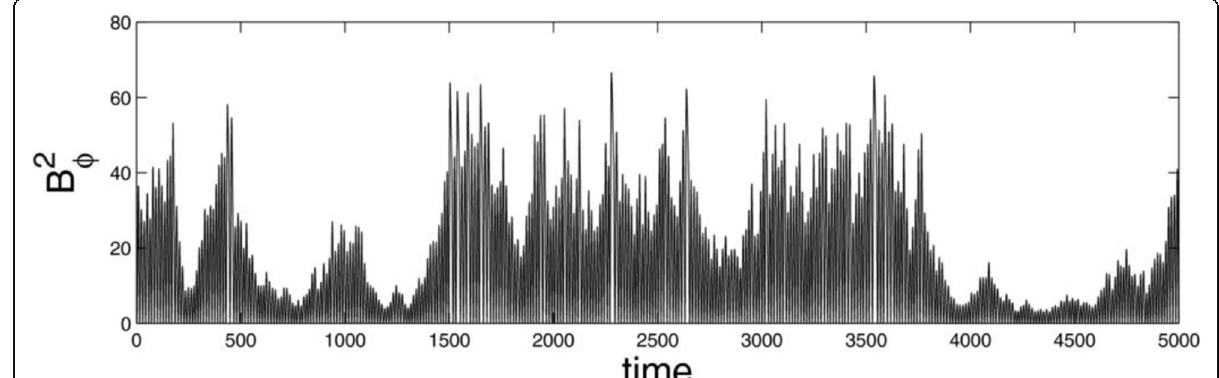
Fig. 7 Evolution of magnetic energy proxy versus time in a reduced, time-delay solar dynamo model with non-linearity and stochastic forcing (Hazra et al. 2014). These very long-term simulations recover the existence of grand maxima and minima phases which are intermittently distributed over the course of the simulations